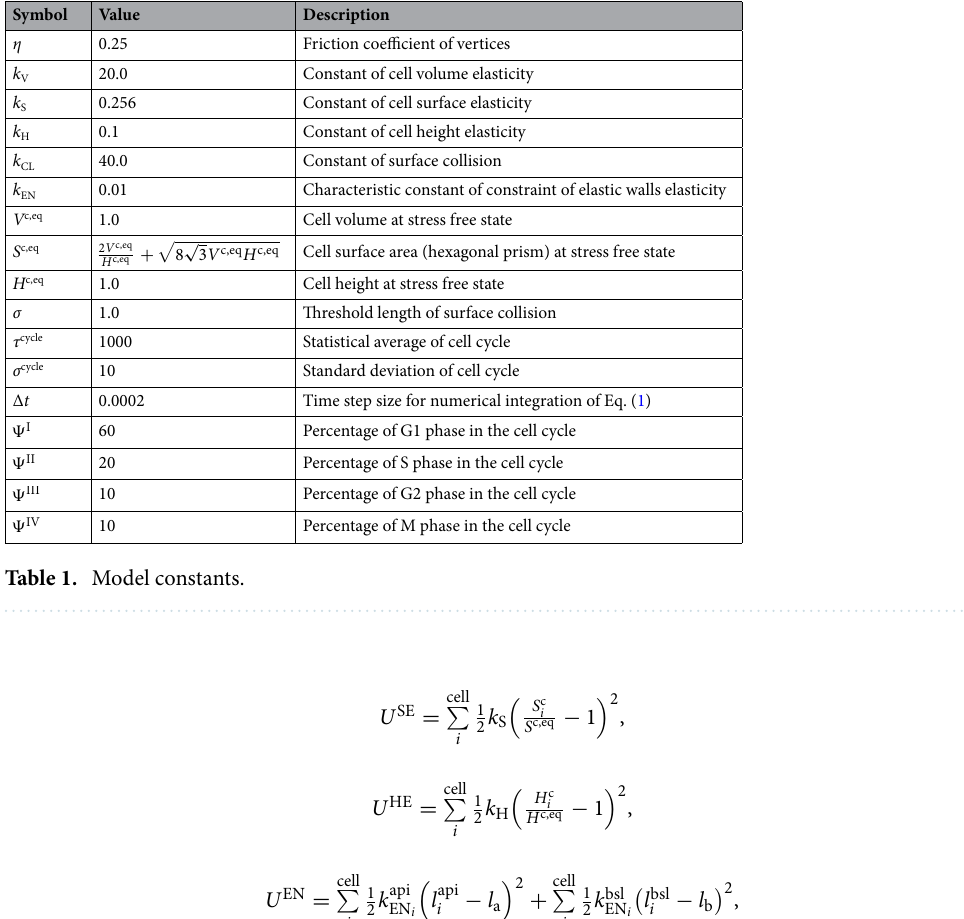
api S bsl where k EN represents the characteristic elasticity coefficient of the wall, and S i and i represent the apical and basal surface areas of the i -th cell, respectively. In this study, tissue growth is represented by the cell proliferation model 27 . Cell division is represented by the division of polyhedral, and cell growth is represented by changes in V c, eq and corresponding changes in S c,eq ( H c,eq is set constant). Each cell is assumed to divide along the long axis of the cross sectional cell shape normal to apicobasal axis. Each cell is constrained to adopt the shape of prism and to always have a basal and apical side. The cell cycle is represented by the mean cycle period τ cycle and its standard deviation σ cycle . The percentages of the duration of G1, S, G2, and M phases within the cell cycle are set as (cid:31) I , (cid:31) II , (cid:31) III and (cid:31) IV , respectively. This model does not take into account cell removal in this simulation. Table 1 lists all model constants used in this study. Focusing on the folding structures induced by cell proliferation, we used a flat, homogeneous epithelial mon- olayer sheet for the initial condition. In the initial state, the tissue consists of 40 × 40 hexagonal prism shaped cells aligned in a regular hexagonal lattice. The model constants are set so that the initial state is a steady state without cell proliferation. In order to analyze the folding structure, we performed cell proliferation simulation under the periodic boundary conditions at the edges of the tissue. Results Proximity of the elastic wall and peak-to-peak folding distance. This section presents the results of the 3D sheet morphology simulations obtained by altering the degree of constraint on the out-of-surface deformation. In this run, the same degrees of constraint were assumed on both sides of the epithelial sheet. Specifically, each of the following values was entered simultaneously into both l a and l b in Eq. (7): 0.20, 0.30, 0.40, 0.50, 1.0, 1.5, and 2.0.